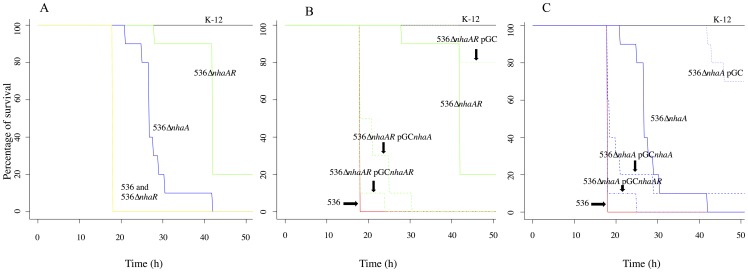
Impact of nhaAR operon on virulence.Lines represent the survival of OF1 mice after subcutaneous injection of 108 cells of the following strains. In (A), (B) and (C) black solid lines, K-12 MG1655 and red solid lines, strain 536. In (A) orange, blue and green solid lines, mice injected with mutants 536ΔnhaR, 536ΔnhaA and 536ΔnhaAR, respectively. In B (C) dashed-dotted lines, complemented mutants 536ΔnhaA pGCnhaAR (536ΔnhaAR pGCnhaAR), dashed lines, complemented mutants 536ΔnhaA pGCnhaA (536ΔnhaAR pGCnhaA), solid lines, 536ΔnhaA (536ΔnhaAR) and dotted lines, complemented mutants 536ΔnhaApGC (536ΔnhaAR pGC).